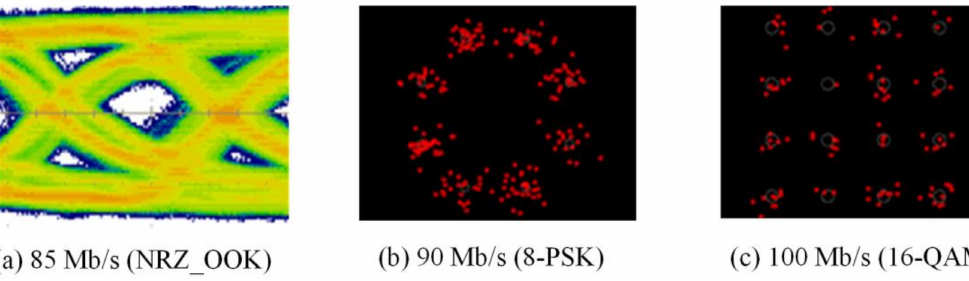
Figure 8. Micro-projection and data transmission of Green LED with bandpass filter (BER = 10 − 3 ).